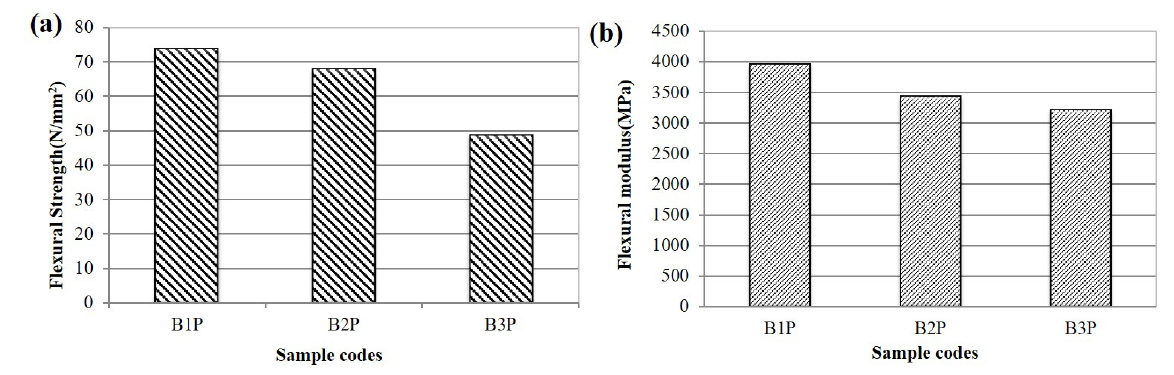
Figure 1: Bending properties of boron/polyester composites a) flexural strength, b) flexural modulus.